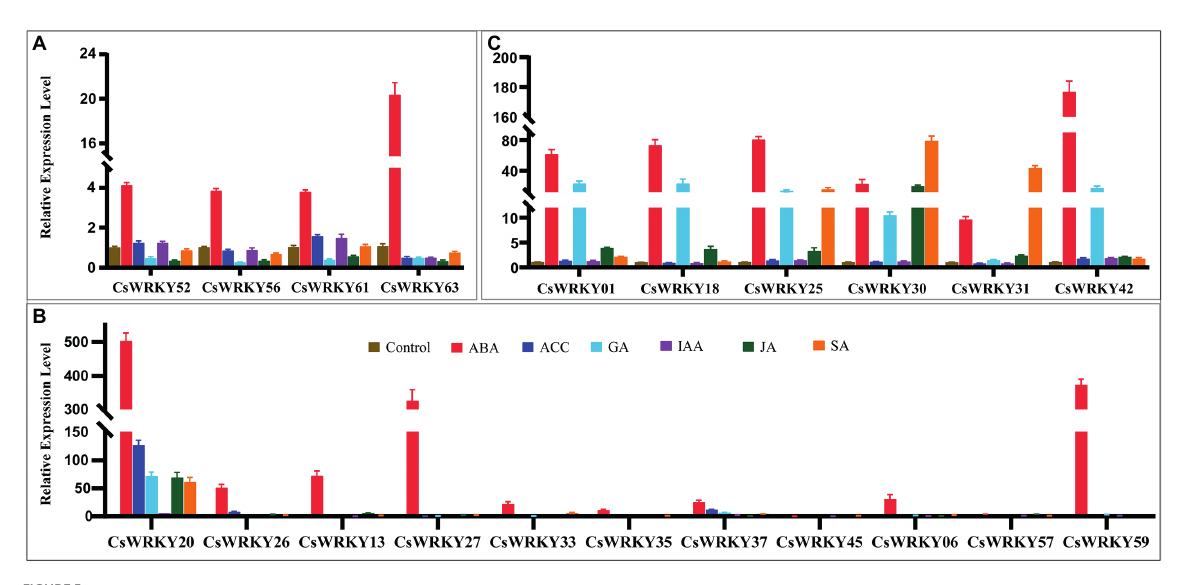
FIGURE 5 Expression patterns of 21 selected CsWRKY genes in C. sinense leaves under ABA, ACC, GA, IAA, JA, and SA stresses ( A . Group I, B . Group II, and C . Group III). qRT-PCR data were normalized using the Cymbidium actin gene. X-axes represent various treatments (CK, normal condition). Different genes and y-axes are scales of relative expression level. Error bars result from three biological